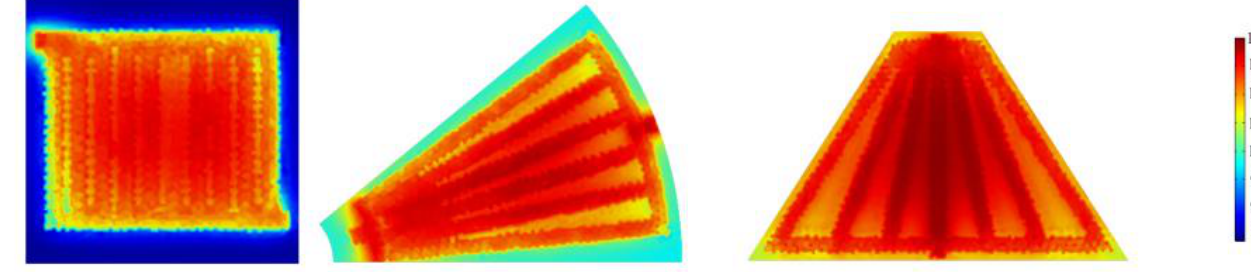
Figure 9. The 2,6-reDHAQ concentration distribution of the 3L/4 cut plane at 0.6 SOC.